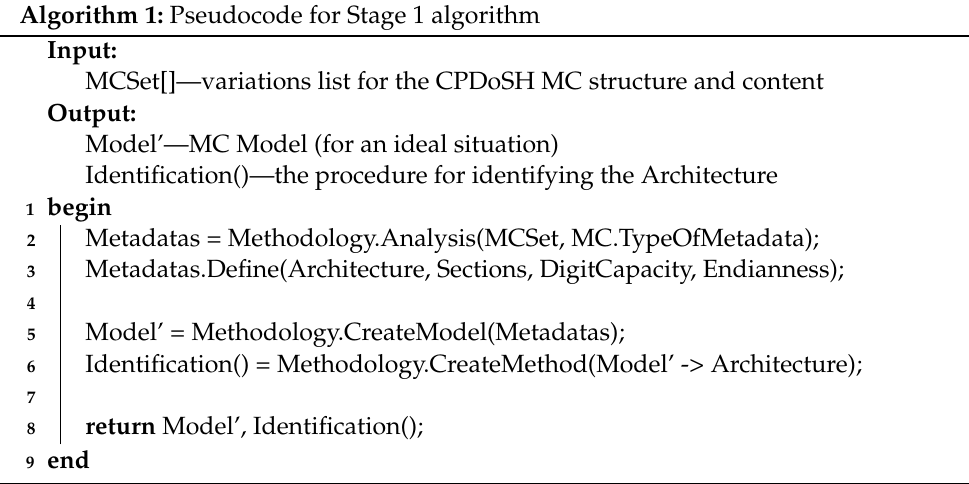
Algorithm 1: Pseudocode for Stage 1